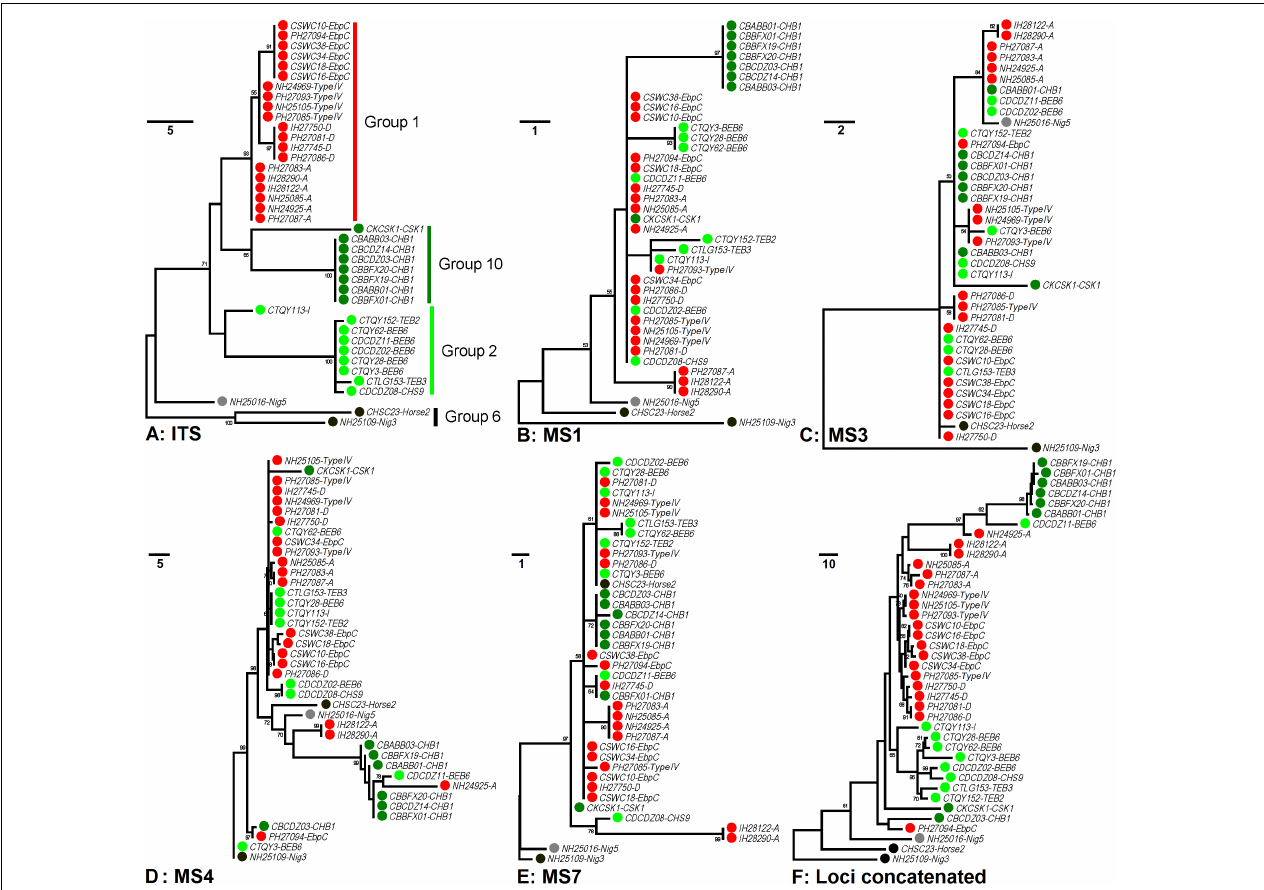
FIGURE 1 | Phylogenetic analysis of individual and concatenated gene datasets of Enterocytozoon bieneusi . Phylogenies at loci ITS (panel A ), MS1 (panel B ), MS3 (panel C ), MS4 (panel D ), MS7 (panel E ), and concatenated (panel F ) were inferred by the maximum-parsimony method implemented in Mega 7 (http://www.megasoftware.net/). The reliability of cluster formation was evaluated by the bootstrap analysis with 1,000 replicates and the values generated greater than 50% were shown beside nodes. The colors (red, dark green, light green, black, and gray) of the circles specified before specimen codes represent the isolates are from ITS Groups 1 ( n = 20), 10 ( n = 8), 2 ( n = 9), and 6 ( n = 2) and an outlier group ( n = 1), respectively. The first initials of isolate names, C, I, N, and P, indicate the isolates were sampled in China, India, Nigeria, and Peru, respectively. The letters B, D, H, K, S, and T followed demonstrate the isolates were sampled from bear, deer, human/horse (only human from India, Nigeria, and Peru was sampled, and horse from China likewise), kangaroo, swine, and takin, respectively. ITS genotypes are specified after specimen